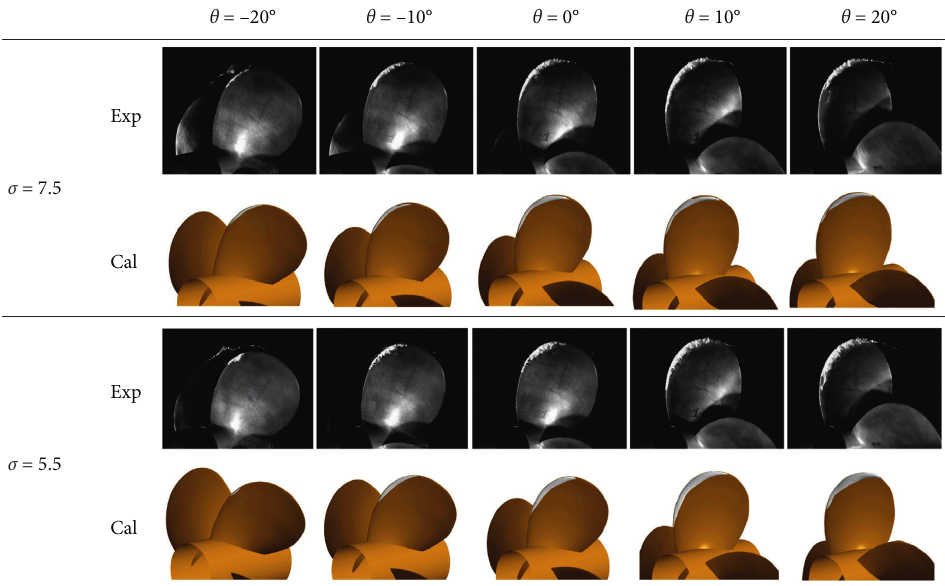
Figure 5: Development of the cavity on the propeller in two different cavitation numbers ( σ � 5.5; σ � 7.5) [1, 17].